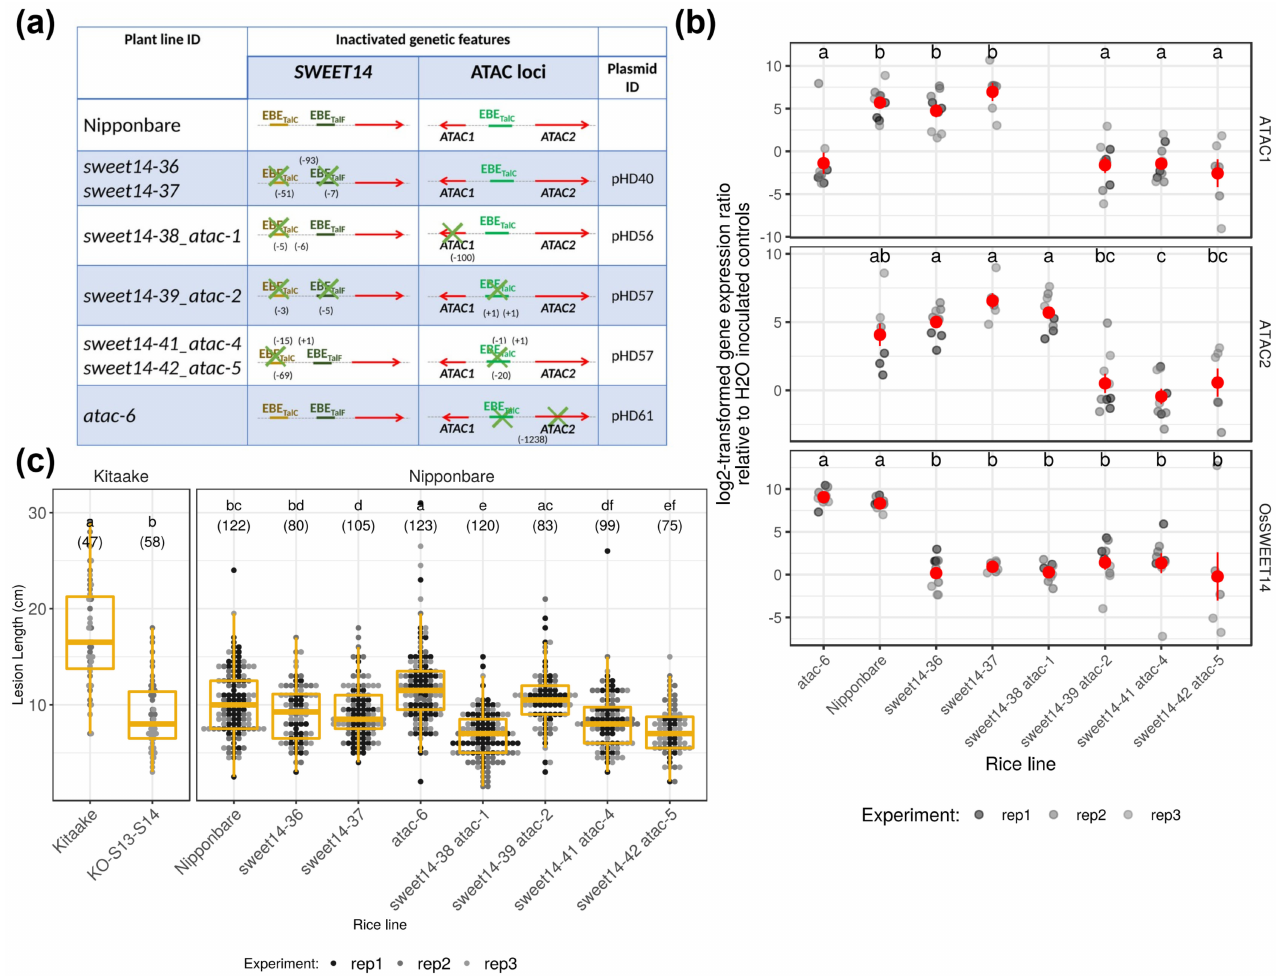
Figure 4. ATAC-locus-edited lines confirm that EBE TalC @ATAC is functional but does not support a role as a BLB disease susceptibility locus. ( a ) A schematic diagram describing the nature of the editing event in the modified Nipponbare homozygous lines characterized below. A cross on top of a functional feature indicates that the sequence of the corresponding allele has been altered. Red arrows represent the OsSWEET14 or ATAC genes. Colored segments depict TALE target EBEs. Values in parentheses aligned with a line identifier inform about the extent and approximate location of DNA editions as in Figure S5. Features are not drawn to scale. ( b ) TalC target transcript expression ratios in multiplex edited lines 48 h post infiltration with BAI3 relative to water-infiltrated control leaves. The plotted data (gray dots) derive from three independent experiments (shades of gray; n = 6–9). The black dots and line ranges denote the mean and the standard error, respectively. Treatments with the same letter in an individual transcript panel are not significantly different (Dunn’s test for post hoc pairwise multiple comparisons; p -value < 0.05). For a couple of genotypes, sequence alterations precluded qRT-PCR on a specific target, and no data are reported (no mean difference letter; see the main text for details). ( c ) Leaf clipping susceptibility assays performed with the edited lines described in panel A challenged with the BAI3 strain. Lesion lengths were measured 14 days post inoculation. Additional water control leaves did not show BLB symptoms. The plotted data derive from three independent experiments (dots with different gray levels). The boxplots represent the median and the first and third quartiles, whereas the whisker extends from the hinge to the largest or the lowest value but no further than 1.5 times the distance between the first and third quartiles. Treatment comparison was performed separately depending on the wild-type rice background, and those with the same letter are not significantly different (Dunn’s test for post hoc pairwise multiple comparisons; p -value < 0.05). Numbers in parentheses represent the count of values for the corresponding